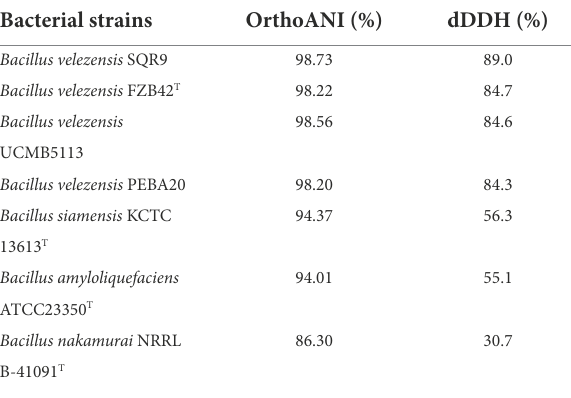
Type strains are indicated by T